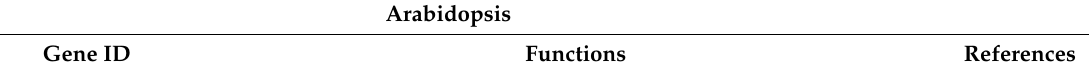
Table 2. List of genes and their roles associated with N stress and ABA in Arabidopsis and wheat.